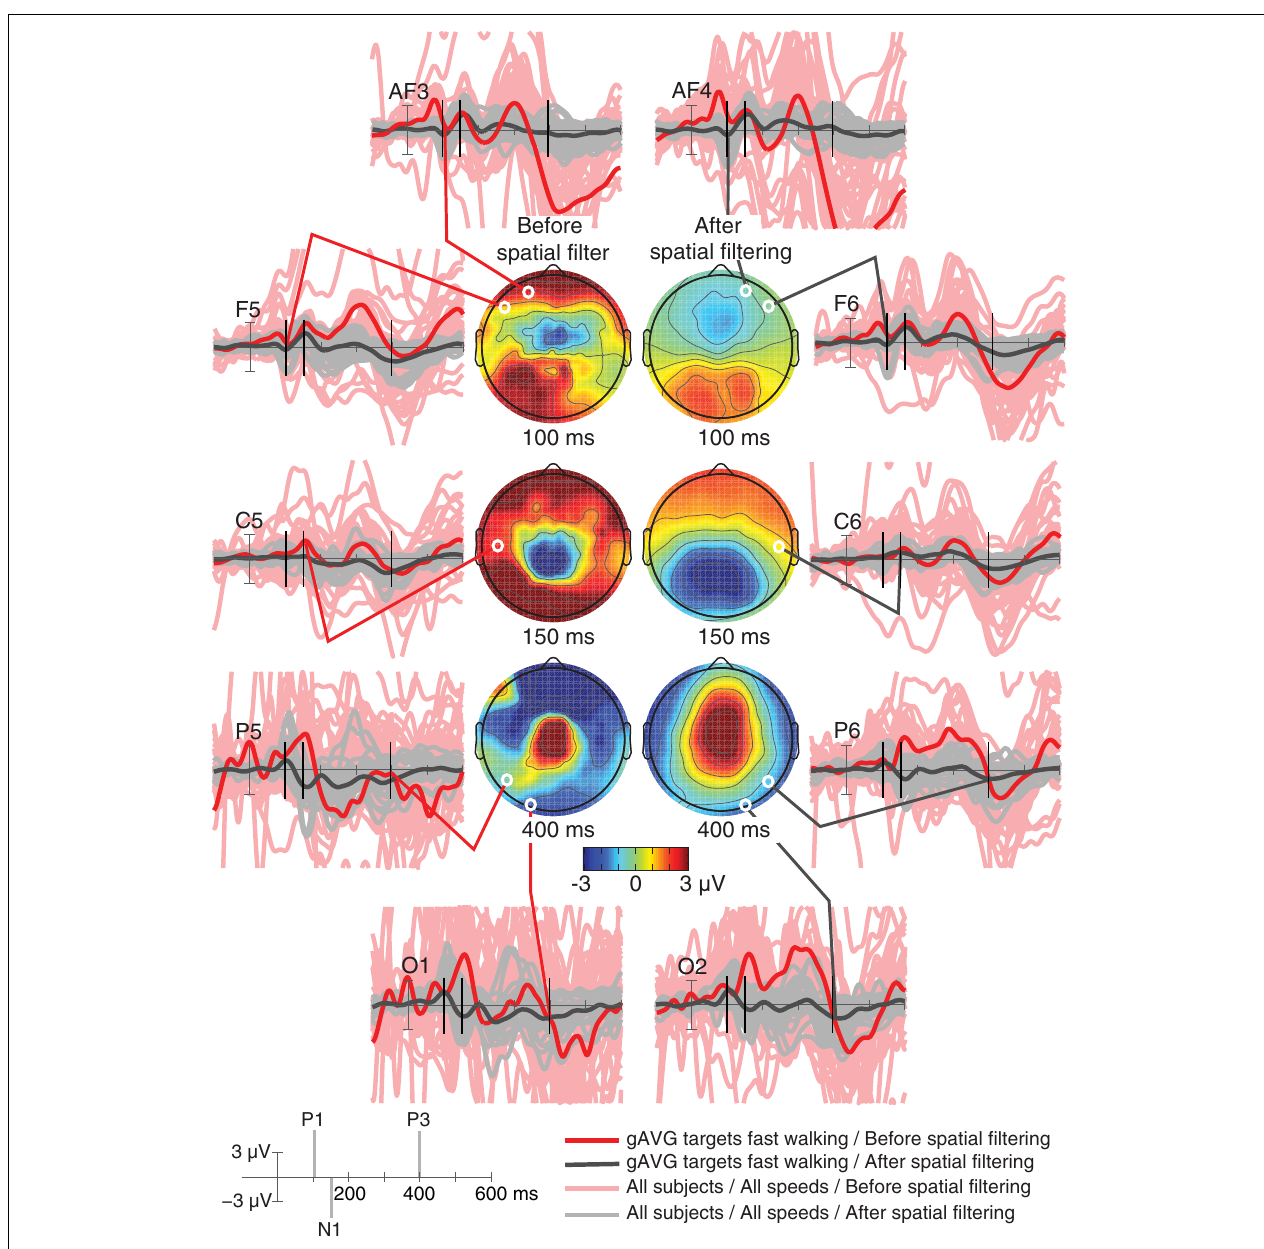
locations in the most contaminated fast walking condition only, before (red) and after (black) removing non-brain independent component (IC) processes. Scalp maps show grand average scalp topographies of the raw (left column) and the artifact-removed ERPs at three peak latencies (100 ms, P1; 150 ms, N1; 400 ms, P3). White dots indicate the locations of the indicated